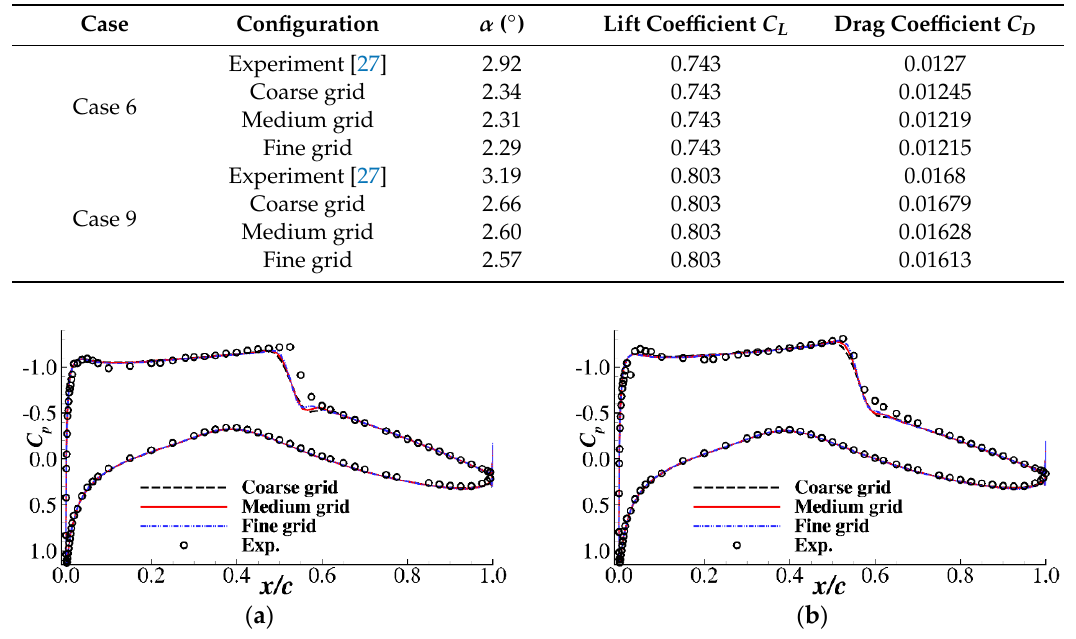
Table 1. Force coe ffi cient comparisons of the RAE2822 airfoil.